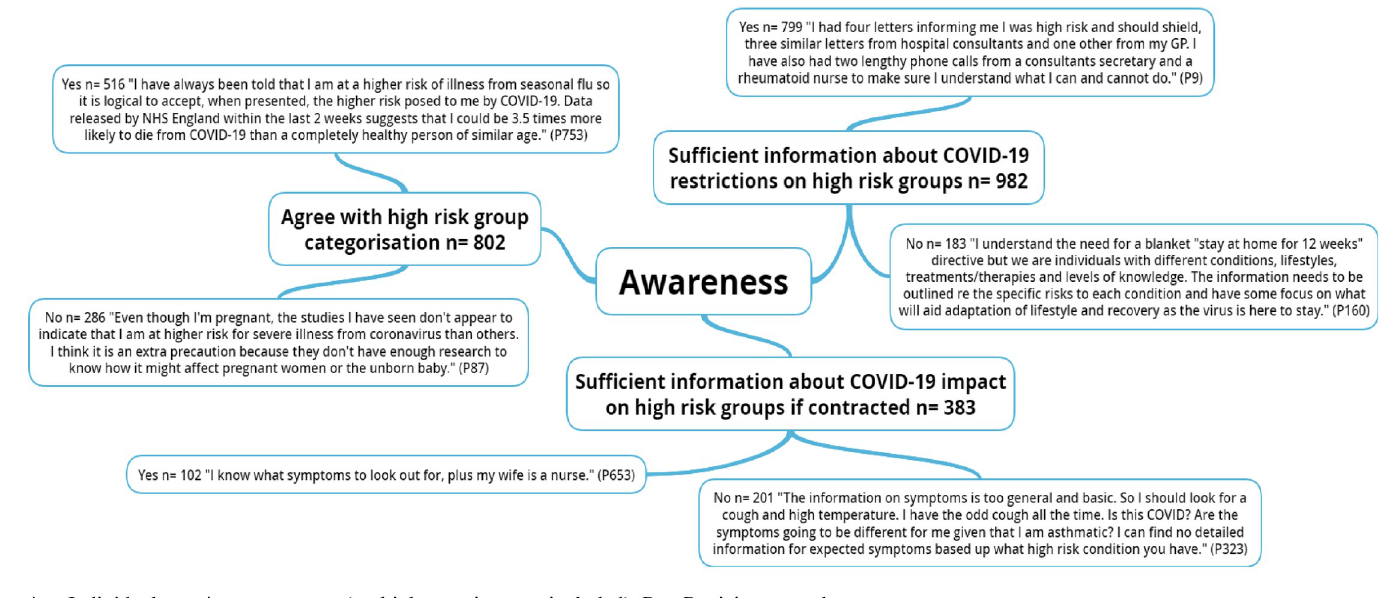
Fig 1. Exploring the awareness of UK adults at high risk of severe illness during the COVID-19 lockdown.